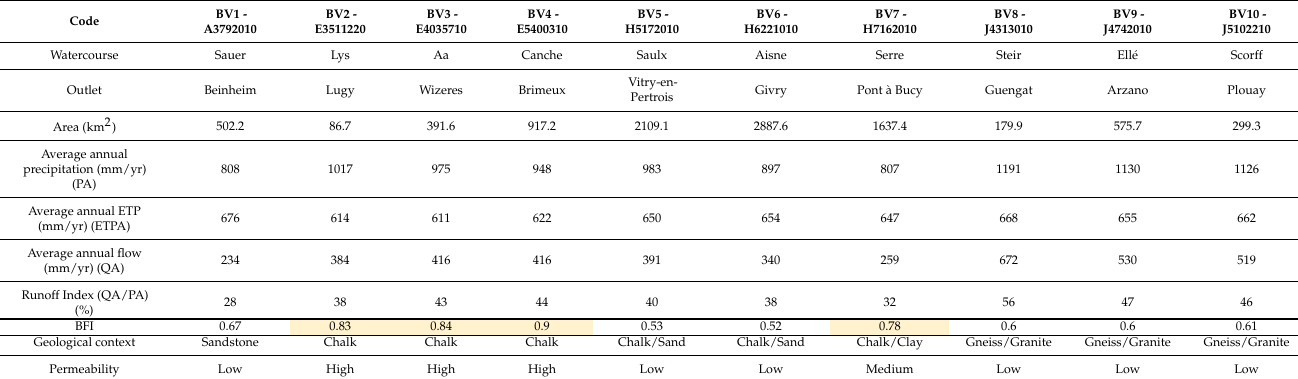
Table 1: Characteristics of the 10 study